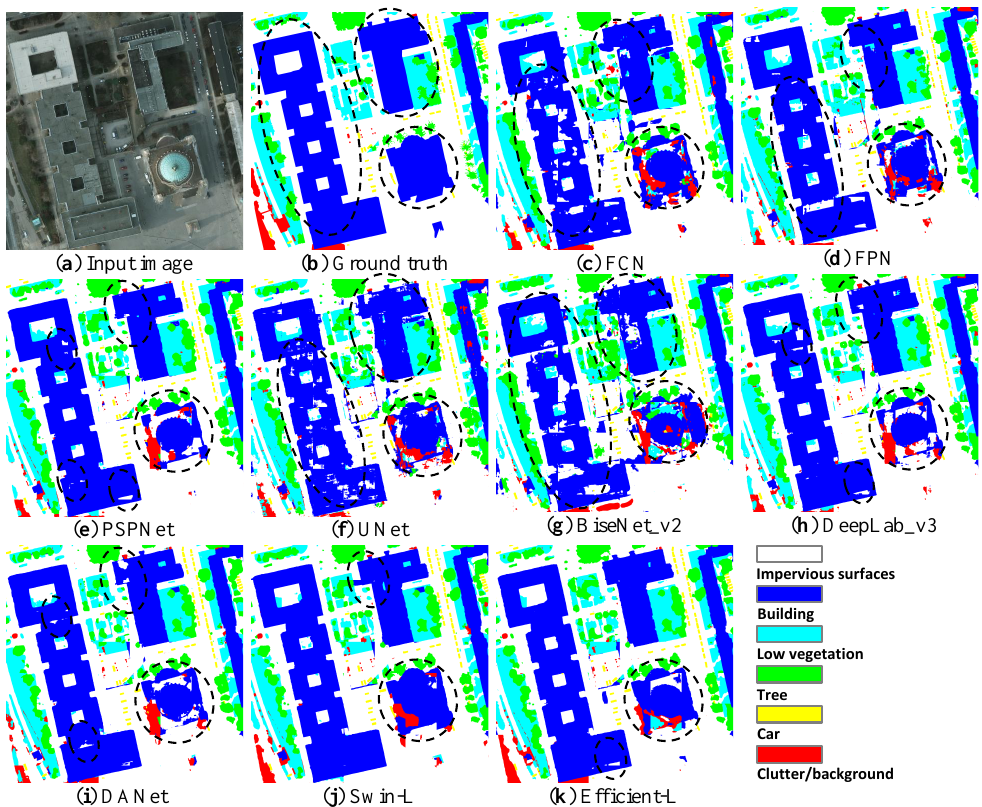
Figure 15. Prediction maps of the compared methods on the Potsdam